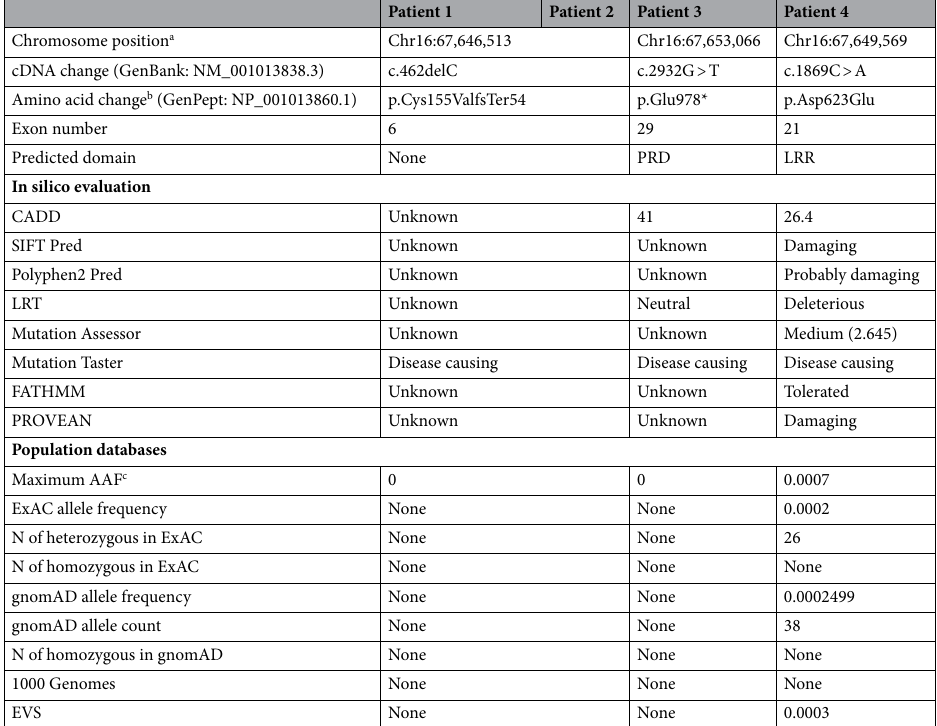
Table 2. Genetic features of CARMIL2-deficient patients. AAF alternative allele frequency, AR autosomal recessive, CADD Combined Annotation Dependent Depletion, EVS Exome Variant Server, ExAC Exome Aggregation Consortium, FATHMM Functional Analysis through Hidden Markov Models, gnomAD Genome Aggregation Database, LRR Leucine-Rich Region, LRT likelihood ratio test, PRD Proline-Rich Domain, PROVEAN Protein Variation Effect Analyzer. a According to human genome assembly GRCh38. b According to NCBI reference sequence NP_001013860.1. c Represents the maximum AAF of a variant in the databases taken into